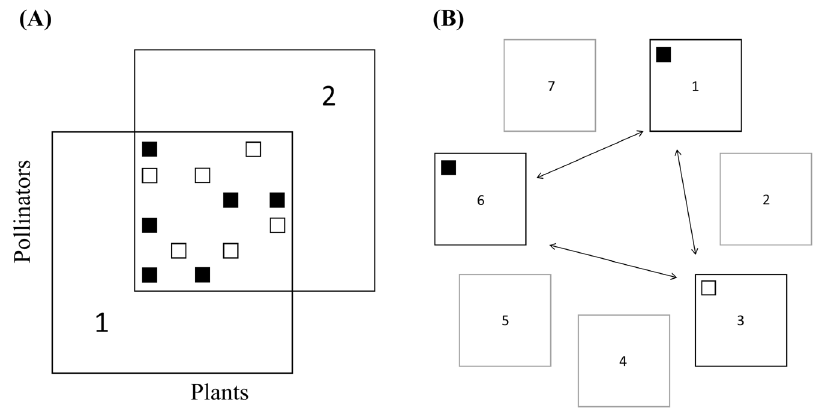
Figure 1. Site-pair comparison and interaction specific site-pair combinations. A) Site-pair comparison. Site 1 and 2 each have unique plants and pollinators. The central square represents the interaction-matrix between shared species. Here, six interactions are present in both sites (interaction consistency, filled squares) and six interactions are only observed in one of the two sites (interaction turnover, open squares). Unique species to either site 1 or 2 were discarded and only the central matrix was used for analysing the turnover of pairwise interactions. B) Interaction specific site-pair combinations. This (hypothetical) interaction is observed at sites 1 and 6 (filled squares) while the species pair is also present at site 3, however without interacting (open square). One or both species are absent from the remaining sites (in grey) and they are excluded from the analysis for this particular interaction. Three site-pair combinations are possible in this case; 1 « 3 and 6 « 3: interaction turnover and 1 « 6: no interaction turnover (interaction consistency).